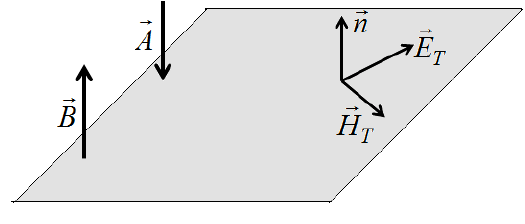
Figure 1: Incident and reflected waves on arbitrary